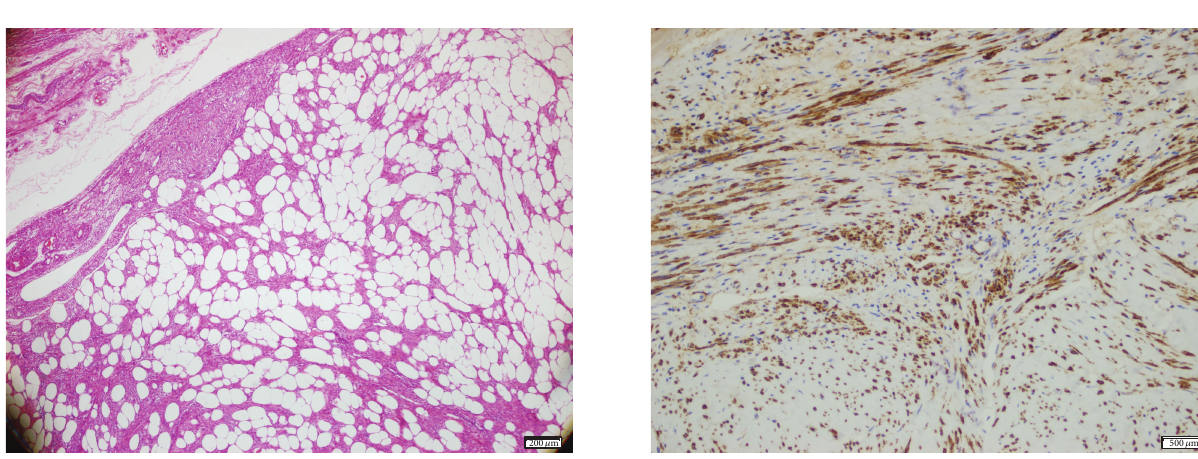
Figure 1: Uterine leiomyoma, H-E × 4.